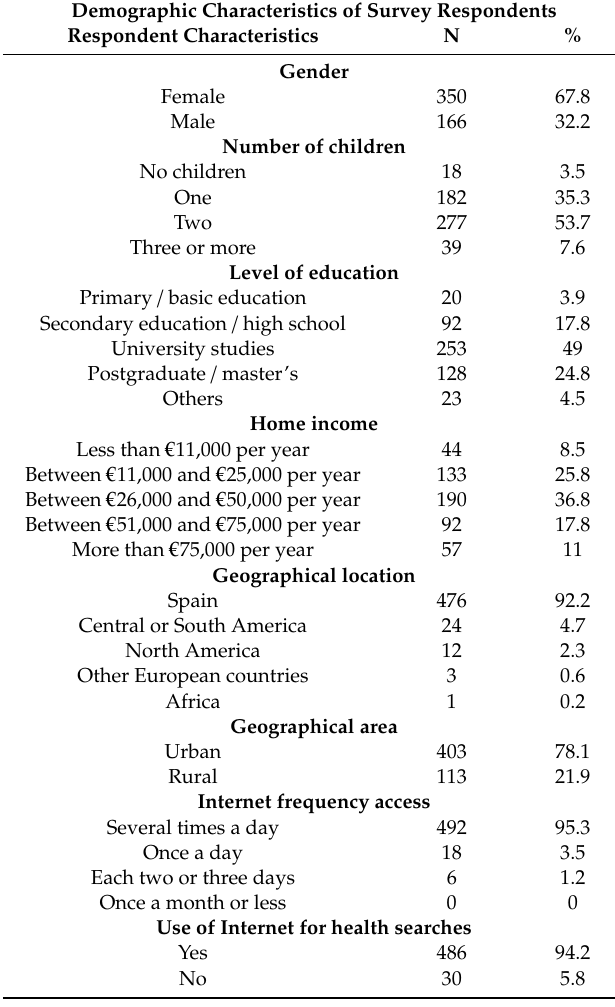
Table 1. Demographic characteristics of survey